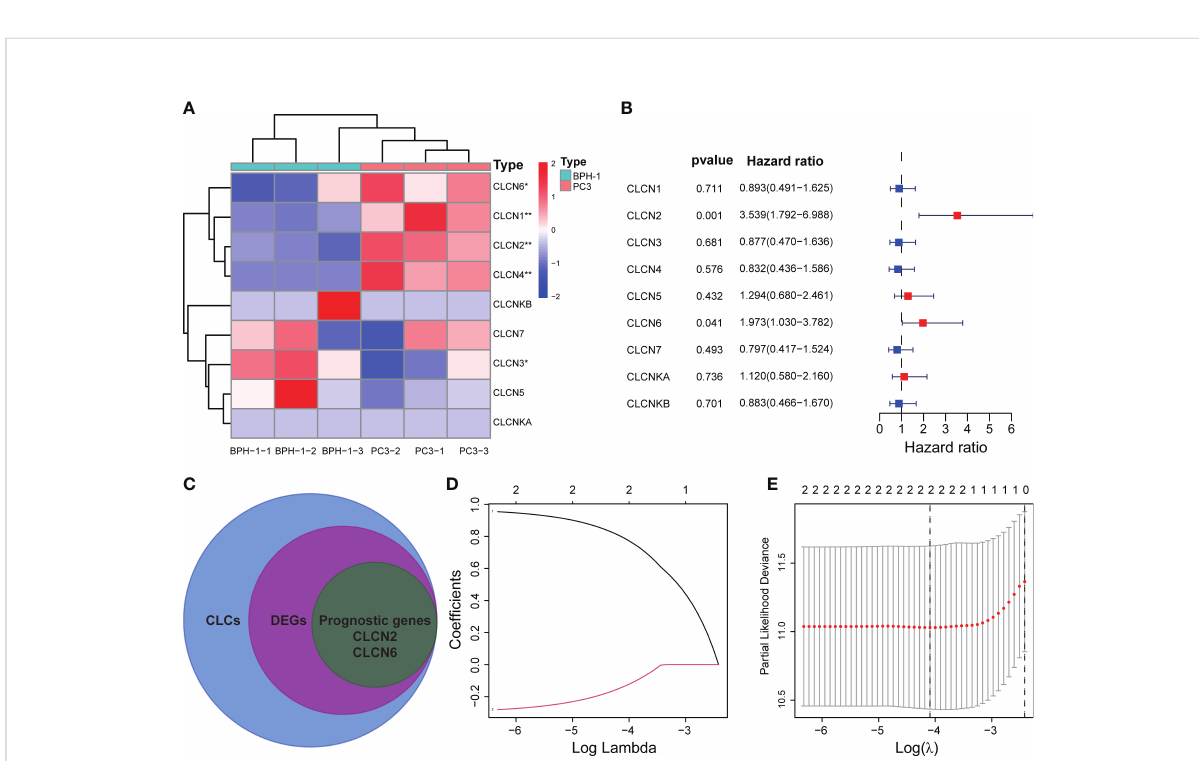
FIGURE 2 Development of the signature. (A) Identi fi cation of differentially expressed CLCs by RNA-sequencing. (B) Univariate Cox analysis of CLCs based on the TCGA-PRAD cohort. (C) Venn diagram of DEGs and prognostic genes. (D, E) Identi fi cation of a CLCs signature by the Lasso-Cox regression. * p<0.05 and ** p<0.01.